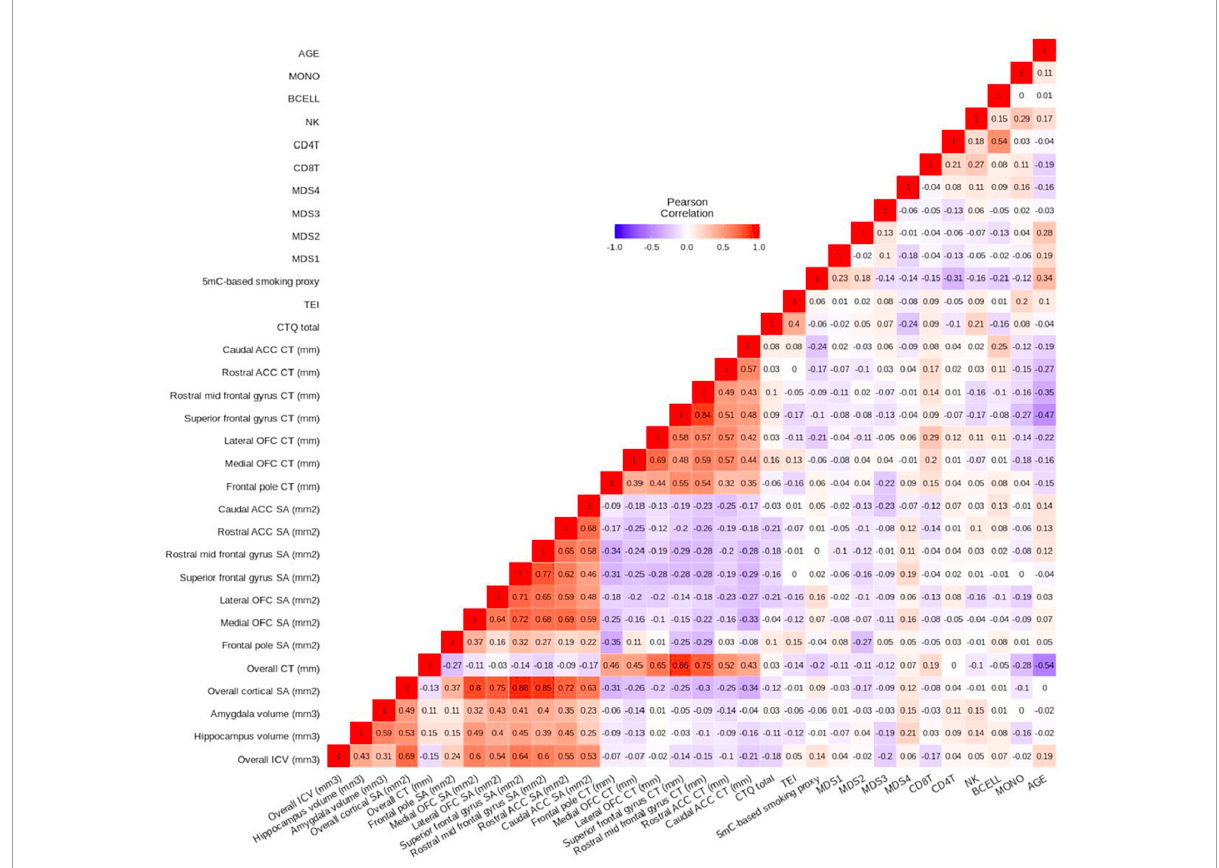
FIGURE2 Pearson’s correlation heatmap of variables used throughout the current study. Age is negatively associated with multiple frontal cortex cortical thickness (CT) measures (Pearson’s correlation r range = − 0.15 to − 0.47, p range = 0.092 to 6 × 10 - 7 ). Within frontal cortex CT measures, multiple subregions show positive correlations with one another (Pearson’s correlation r range = 0.32–0.84, p range = 0.004 to < 2 × 10 - 16 ). The same phenomenon is observed within frontal cortex surface area (SA) measures (Pearson’s correlation r range = 0.16–0.77, p range = 0.210 to < 2 × 10 - 16 ). Overall CT is positively correlated with each of the frontal cortex CT measures (Pearson’s correlation r range = 0.43–0.86, p range = 1 × 10 - 7 to < 2 × 10 - 16 ), and overall SA is positively correlated with each of the frontal cortex SA measures (Pearson’s correlation r range = 0.37–0.88, p range = 5 × 10 - 4 to < 2 × 10 - 16 ).